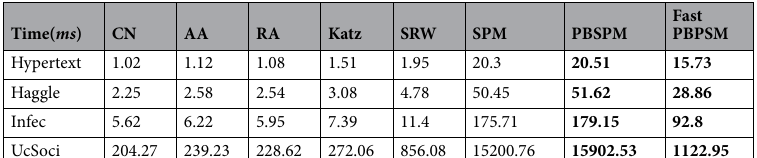
Figure 3. Precision versus m and gap λ λ = − + g matrix A T . Panel (a) shows the performance of Eq. (9) on various m ∈ [1, 30] with fixed p fresher = 0.05 and α = 9. Each data point is obtained over ten simulations. Panel (b) shows the difference g m between λ g 1 = 34.37 is distinct and the others are all close to 0.